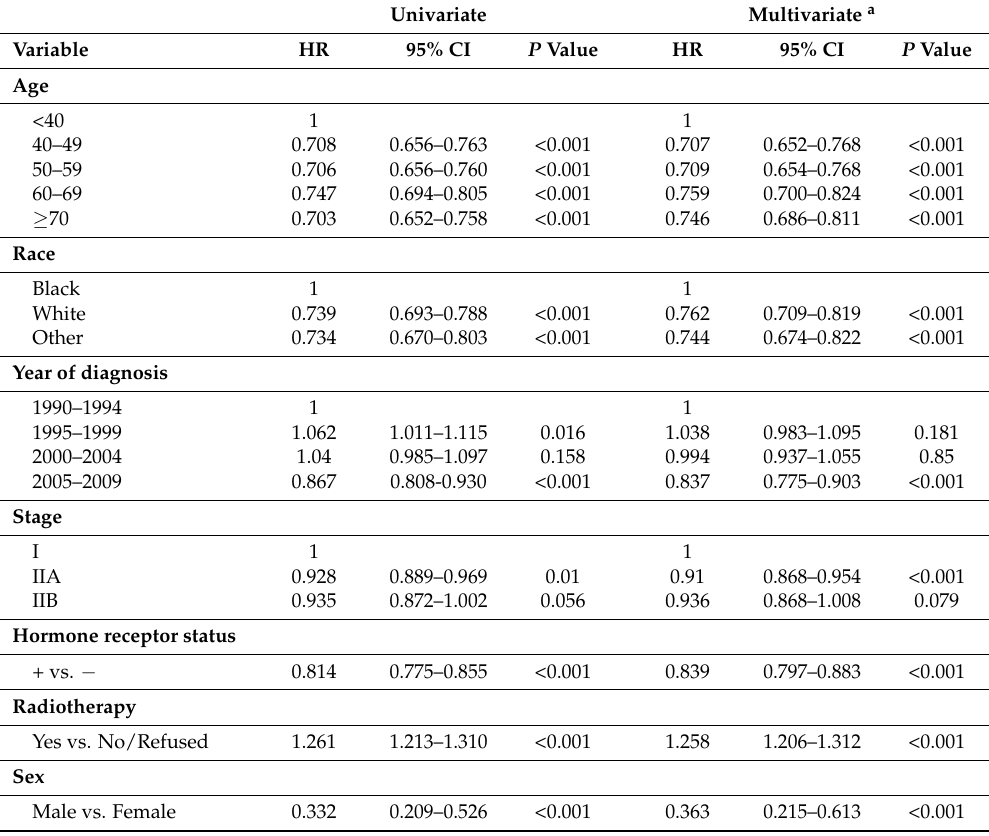
Table 1. Univariate and multivariate Cox regression for the occurrence of contralateral breast cancer (CBC) in early stage breast cancer (BC)